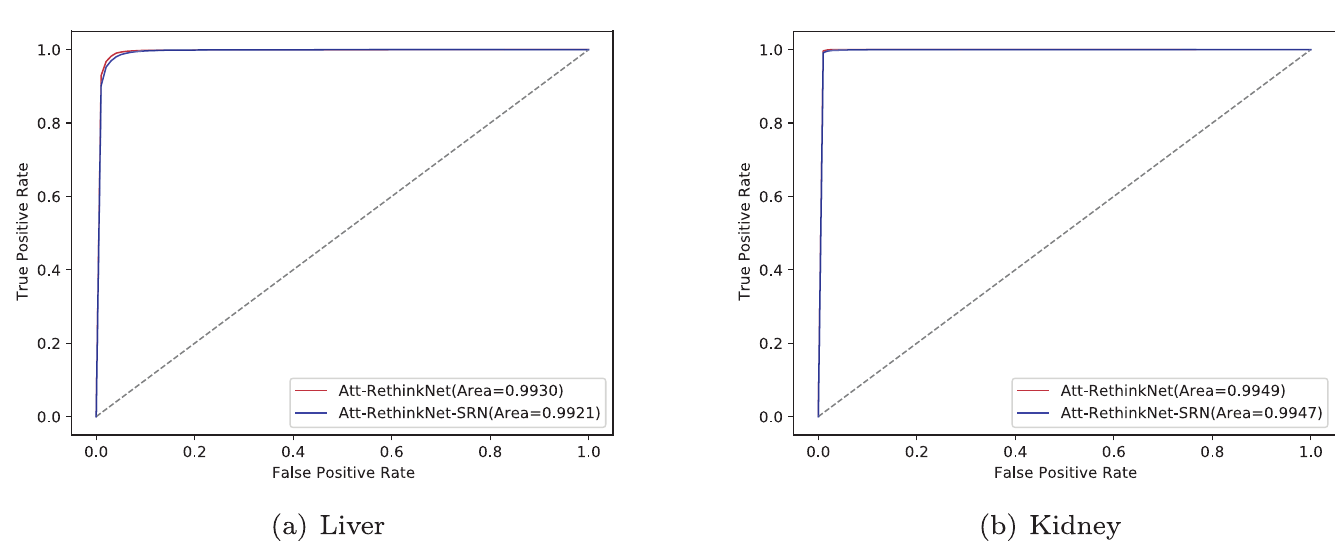
Fig 6. ROC curves of Att-RethinkNet using LSTM and SRN algorithms on liver data (a) and kidney data (b).